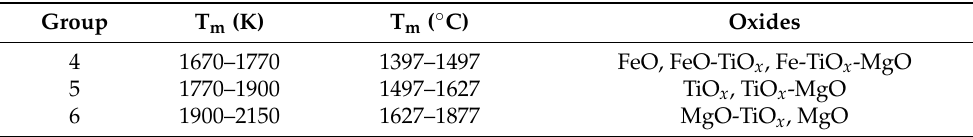
Table 6. Classification of main oxide inclusions in the Ti/Mg experiments by using FGA measure-